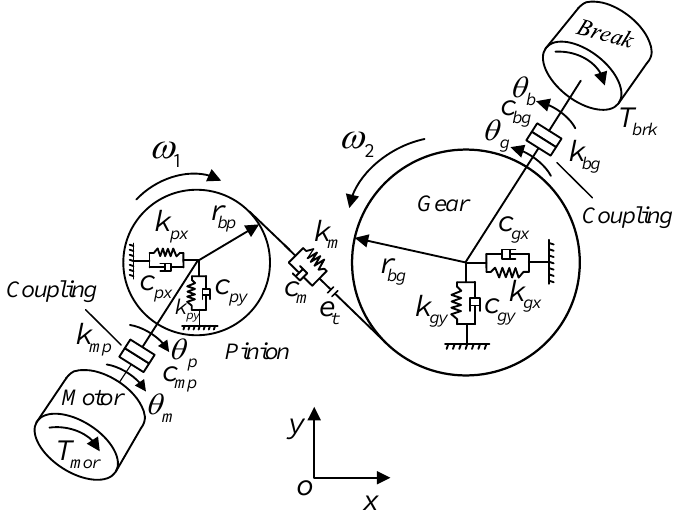
Figure 1. Diagram of the gear dynamic model.